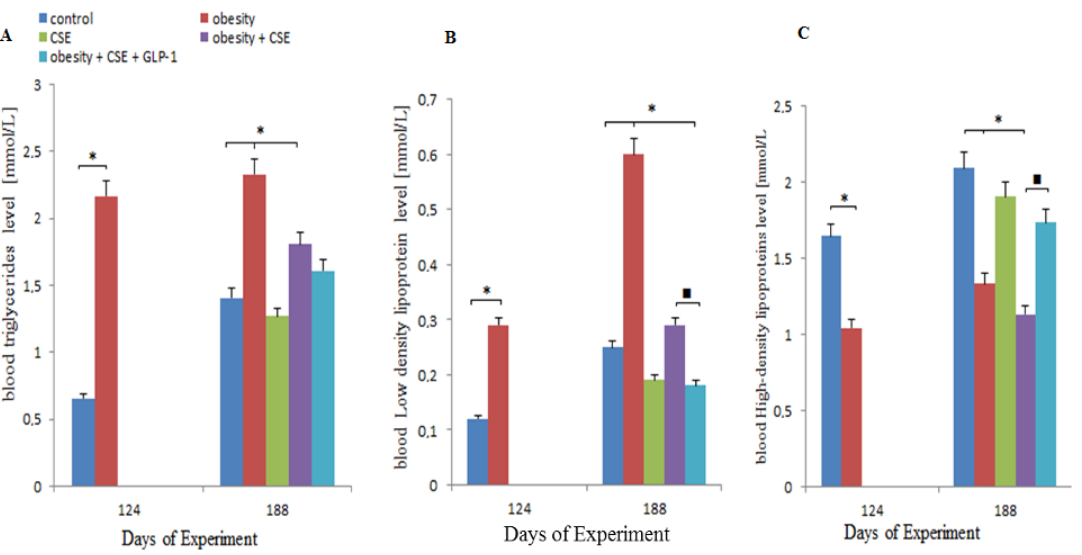
Figure 1. Lipid profile measurements in the blood of female C57BL/6 mice with obesity (the 124th day of the experiment) and obesity + CSE (the 188th day of the experiment): the level of triglycerides in serum ( A ); low-density lipoprotein level ( B ); high-density lipoprotein level ( C ). *—significance of difference compared with control ( p < 0.05); (cid:4) —significance of difference compared with the obesity + CSE group ( p <